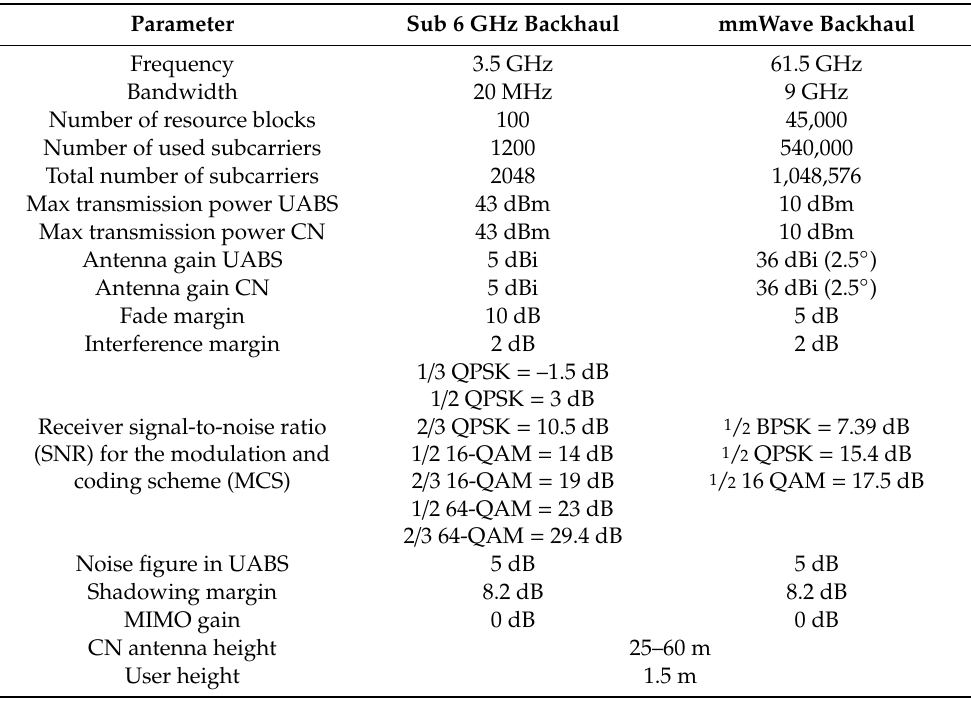
Table 2. Link budget parameters for the